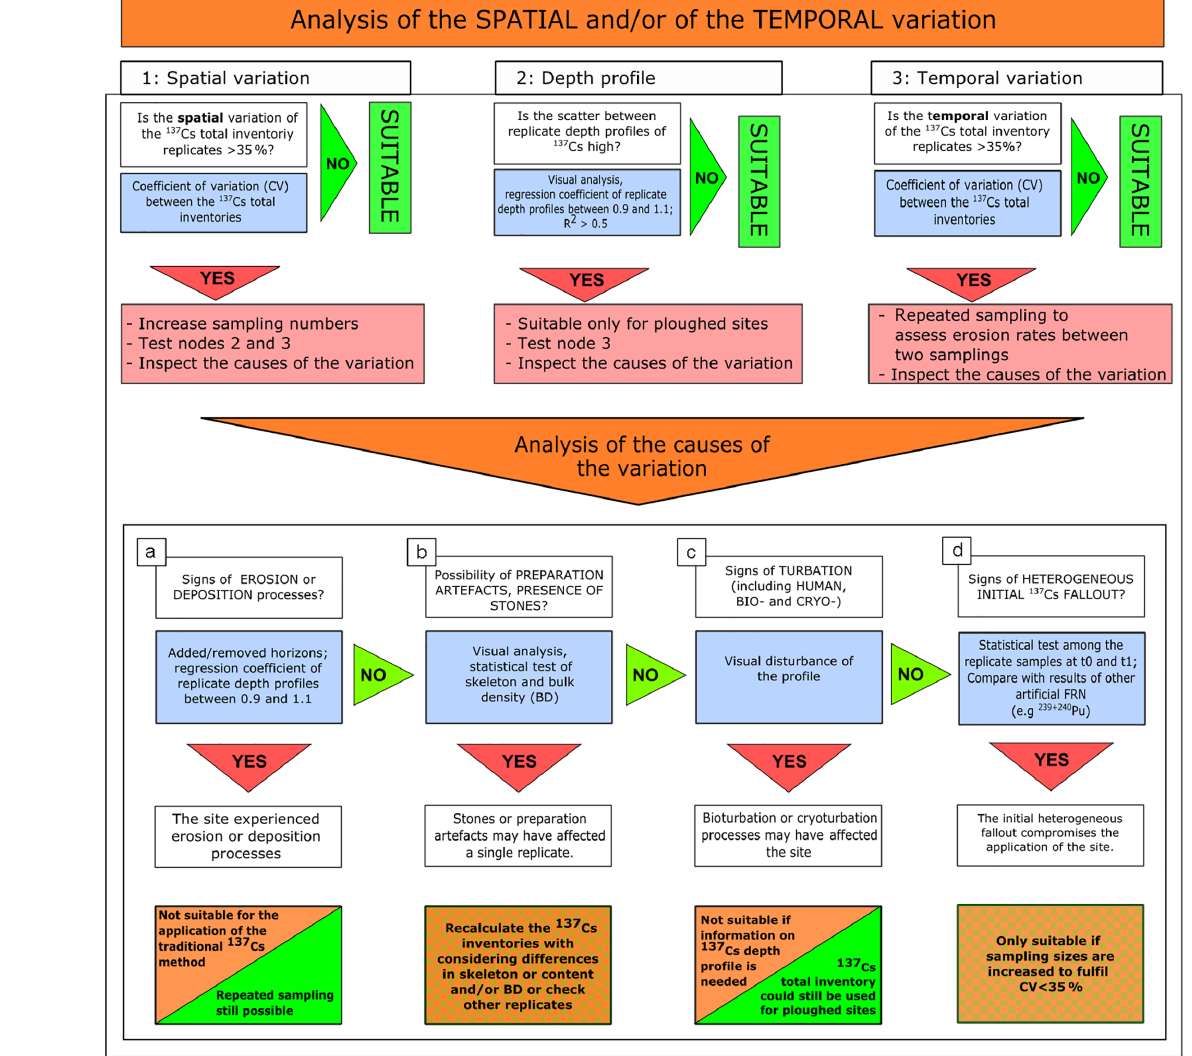
Figure 2. The CheSS decision tree to evaluate the suitability of a reference site for using 137 Cs as a soil erosion